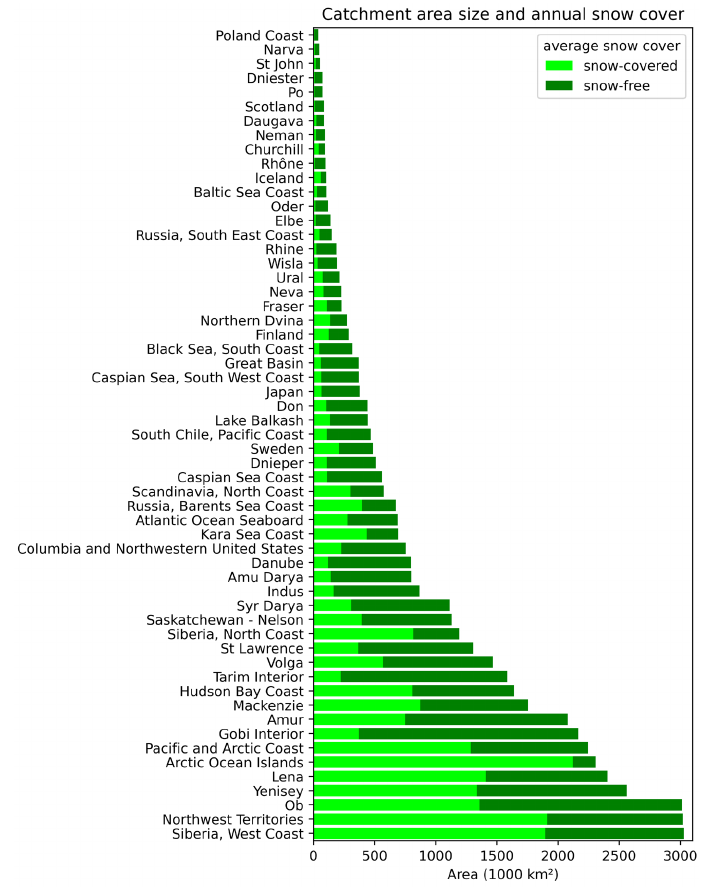
Figure 4. Overview of the area extent of the selected basins and their mean snow cover (basins obtained from [46]).